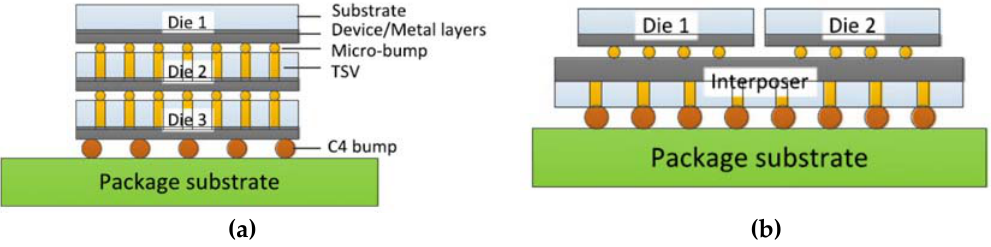
Figure 43. (a) Three-dimensional integration of multiple dies using through silicon vias (TSVs); ( b ) 2.5D integration of multiple dies using an interposer.